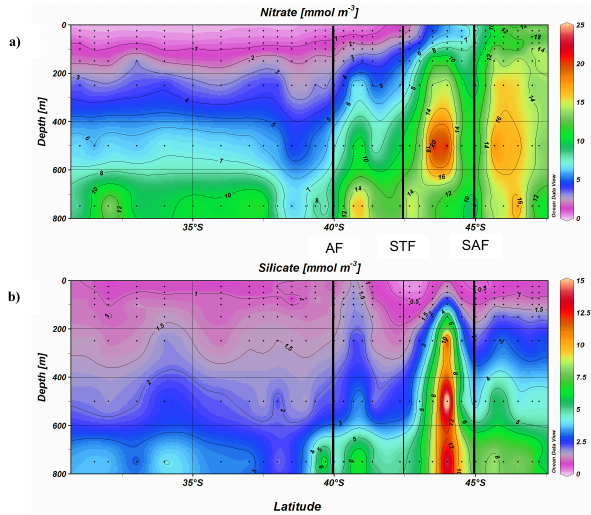
Fig. 4. CTD sections of (a) nitrate (mmolm − 3 ) and (b) silicate (mmolm − 3 ) for the Southbound Transect to 800m. Data points are indicated as black dots. The position of the Agulhas Front (AF), Subtropical Front (STF) and Subantarctic Front (SAF) are marked as bold vertical lines. Plots made using Ocean Data View (Schlitzer,